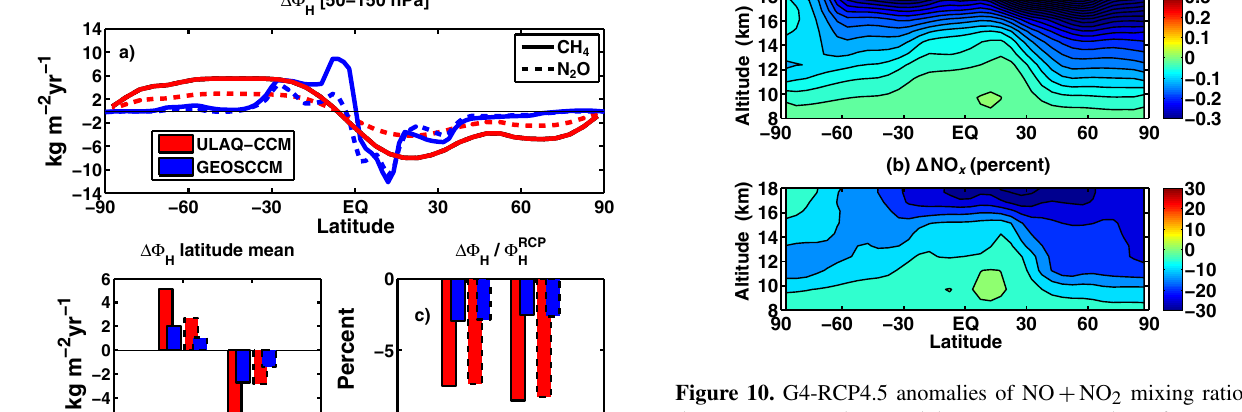
Figure 10. G4-RCP4.5 anomalies of NO + NO 2 mixing ratios in the upper troposphere and lowermost stratosphere from experi- ment (b) of the ULAQ-CCM (time average 2040–2049). Panels (a, b) are for absolute (ppbv) and percent NO x changes, respectively. Figure 8. As in Fig. 7 but for horizontal mass flux anomalies G4- The contour line increments are 0.025ppbv and 5% in panels (a, RCP4.5 (vertical average 50–150hPa; time average 2040–2049). b) , Units are kgm − 2 yr − 1 . The horizontal flux anomalies (cid:49)(cid:56) H are de- fined as (cid:49) [ vρ CH ] and (cid:49) [ vρ N ], where v is the 3-D meridional 4 2 O wind component.